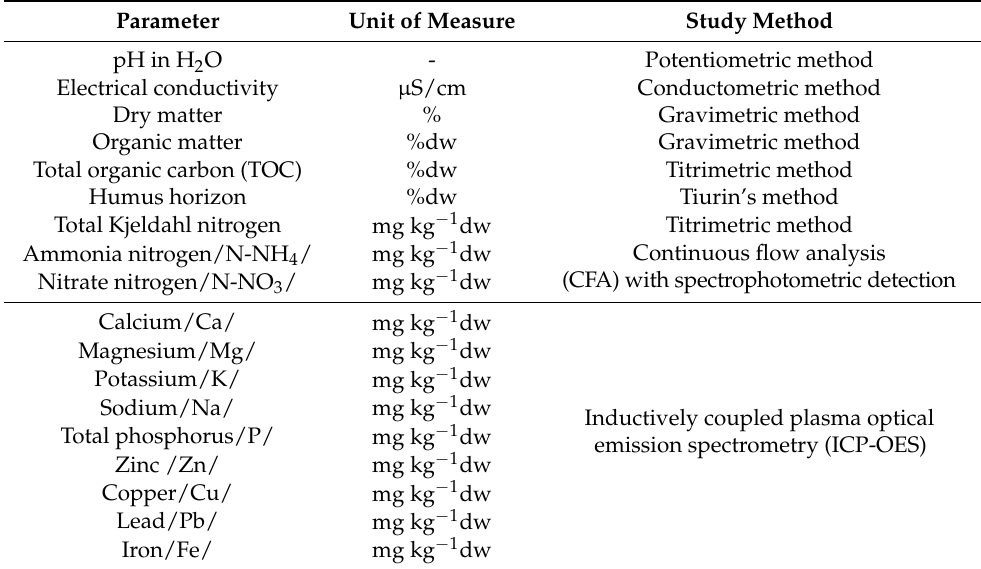
Table 2. Soil parameters laboratory research